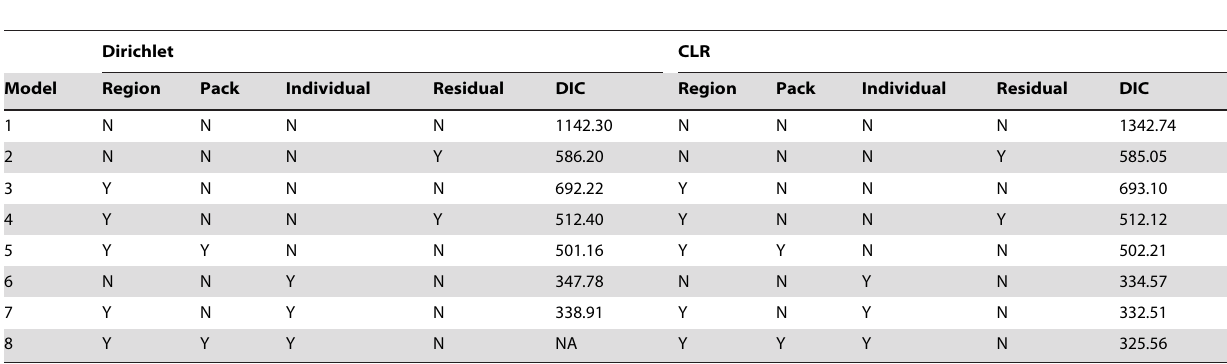
Table 1. Summary of results for 8 stable isotope mixing models explaining variation in diet for 64 wolves in British Columbia.